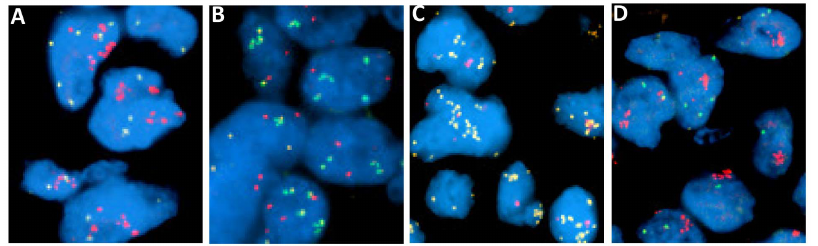
Figure 1. Specimen B5b showing gene amplification for FGFR1 (A, red) and BRF2 (B, green) and low copy number for SOX2 (A, gold), and PIK3CA (B, red); specimen C4d showing gene amplification for SOX2 (C, gold) and PIK3CA (D, red) and low copy number for FGFR1 (C, red) and BRF2 (D, green).